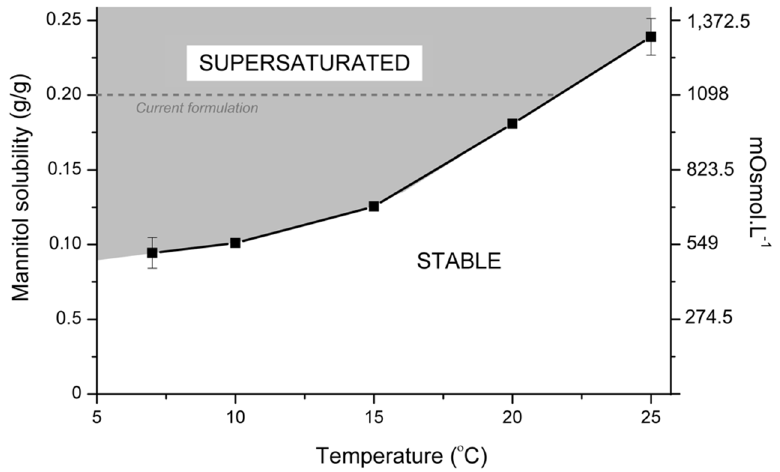
Figure 3. Solubility curve for mannitol in deionised water from 7 to 25 °C with the corresponding mOsmol·L − 1 of mannitol solution at equilibrium calculated using Equation (1).